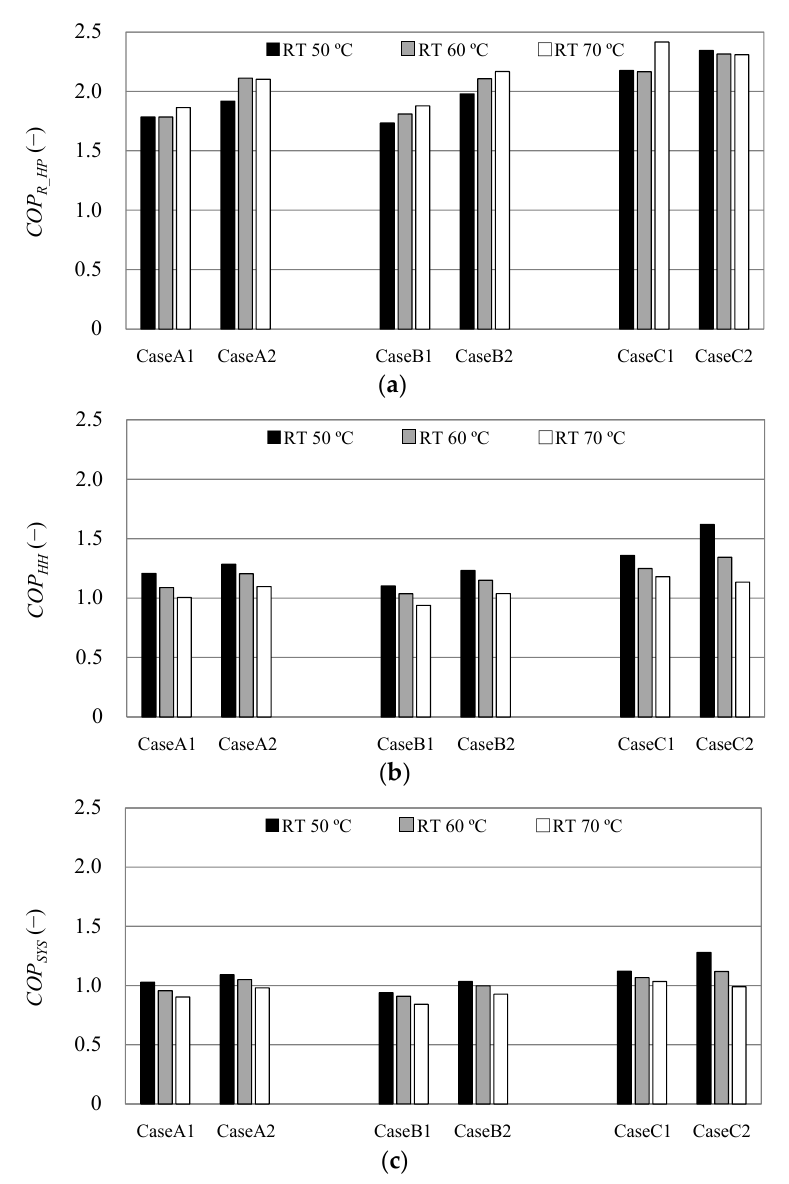
Figure 7. ( a ) Heating efficiency of the heat pump for regeneration ( COP R_HP ), ( b ) Humidification ‐ heating efficiency of the heat ‐ source side ( COP HH ), ( c ) Humidification ‐ heating efficiency of the whole system ( COP SYS ). RT = regeneration temperature.